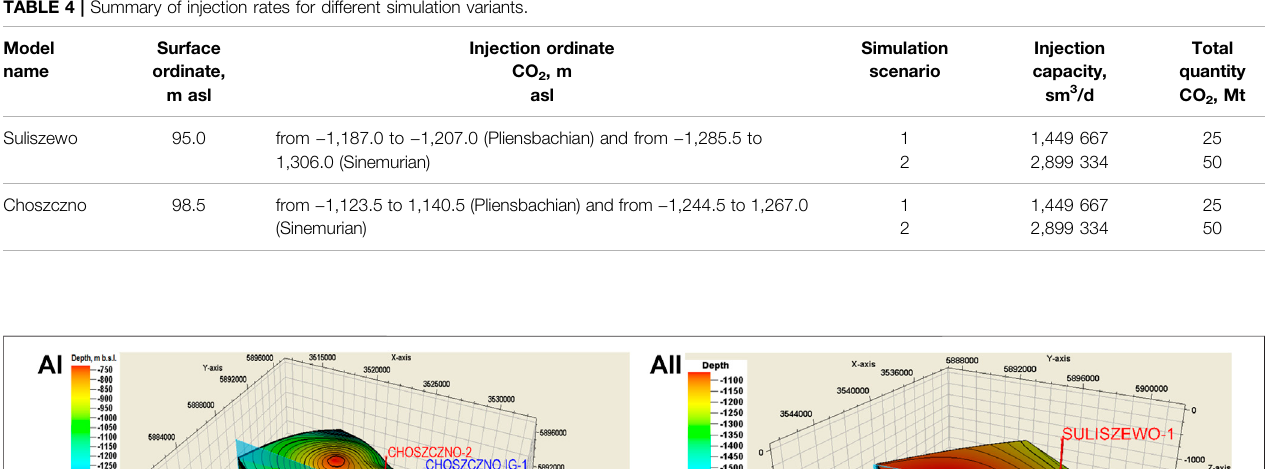
Frontiers in Energy Research |